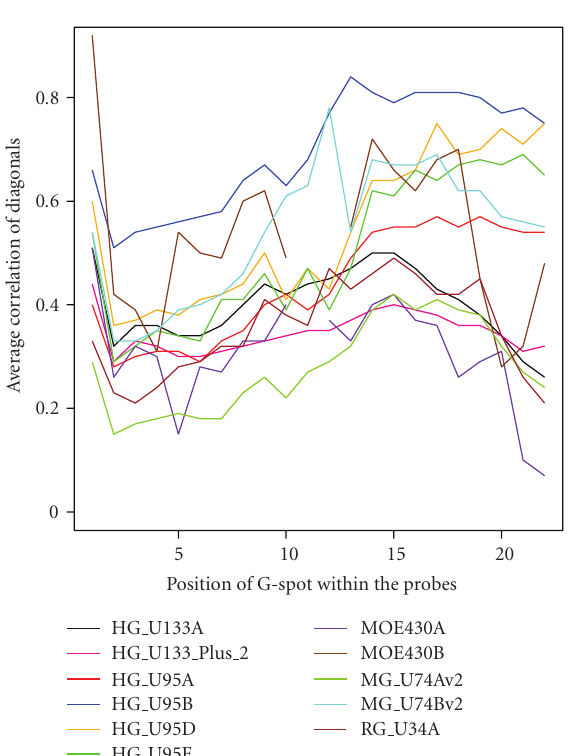
Figure 3: The plot shows that diagonal correlation coe ffi cient values of each chip design. Diagonal values represent correlation among the same group of